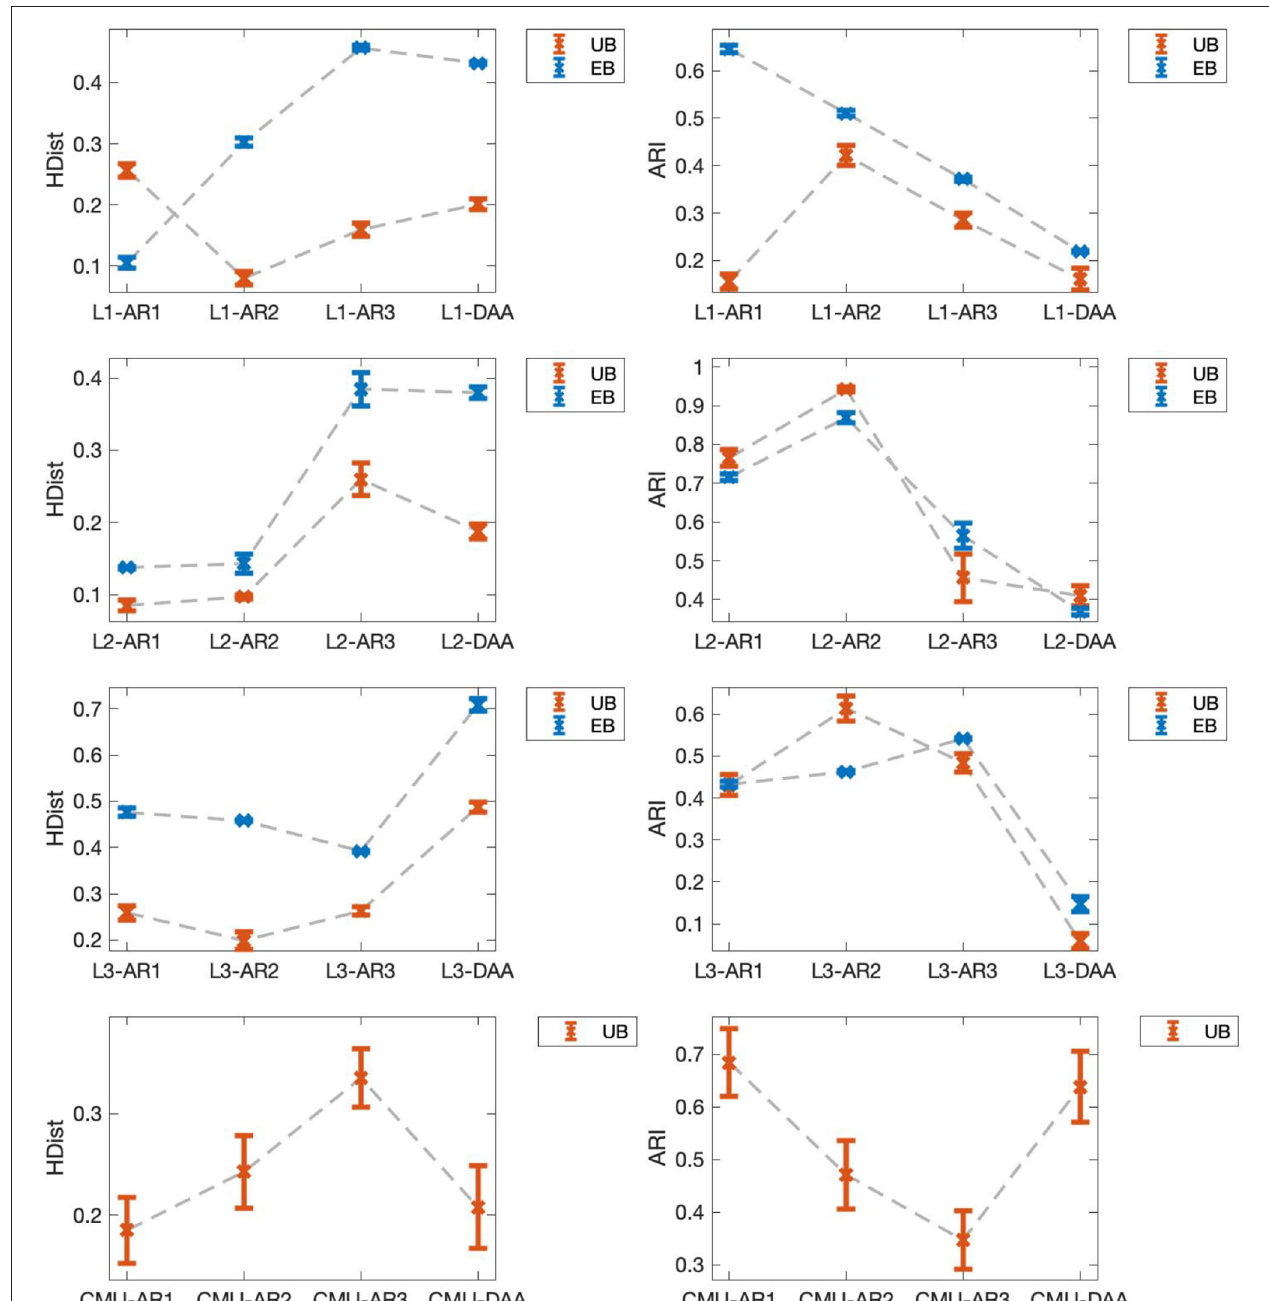
FIGURE 5 | Evaluation of model accuracy. (Left) Average normalized Hamming distances. Bars: 1 SE. Lower value is better. (Right) Average adjusted Rand index. Bars: 1 SE. Higher value is better.